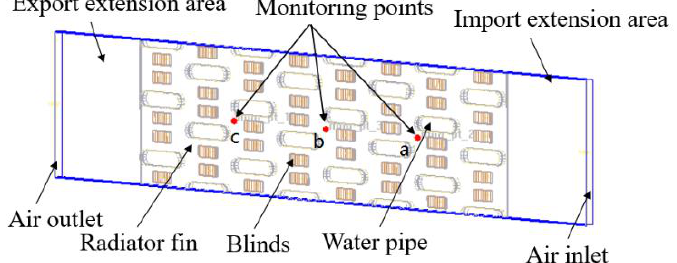
Figure 3. Structural calculation model of the radiator.